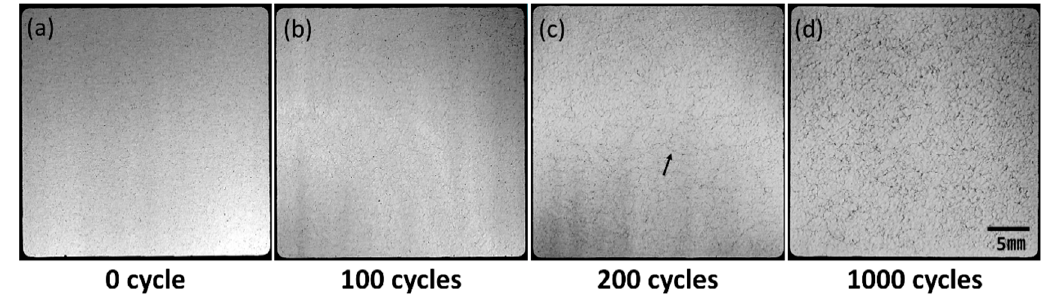
Figure 5. Scanning acoustic tomography (SAT) observation of the surface morphology of the Ni–P layer on AMB substrates with Si 3 N 4 after different thermal shock tests: 0, 50, 100, and 1000 cycles.